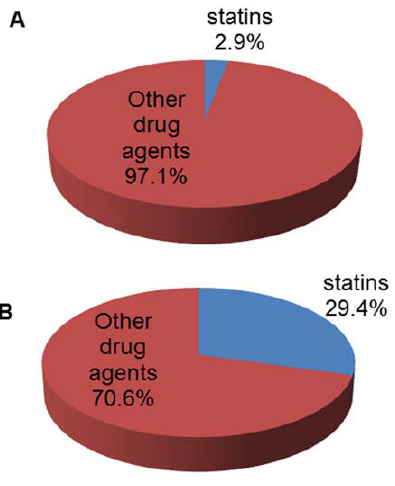
Figure 1. Exposure to statins in cases and non-cases. 1A. Exposure to drugs in reports of other adverse drug reactions (non- cases). 1B. Exposure to drugs in reports of polymyalgia rheumatica